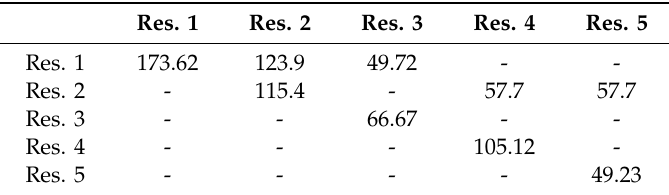
Table 2. The upper bounds of release.